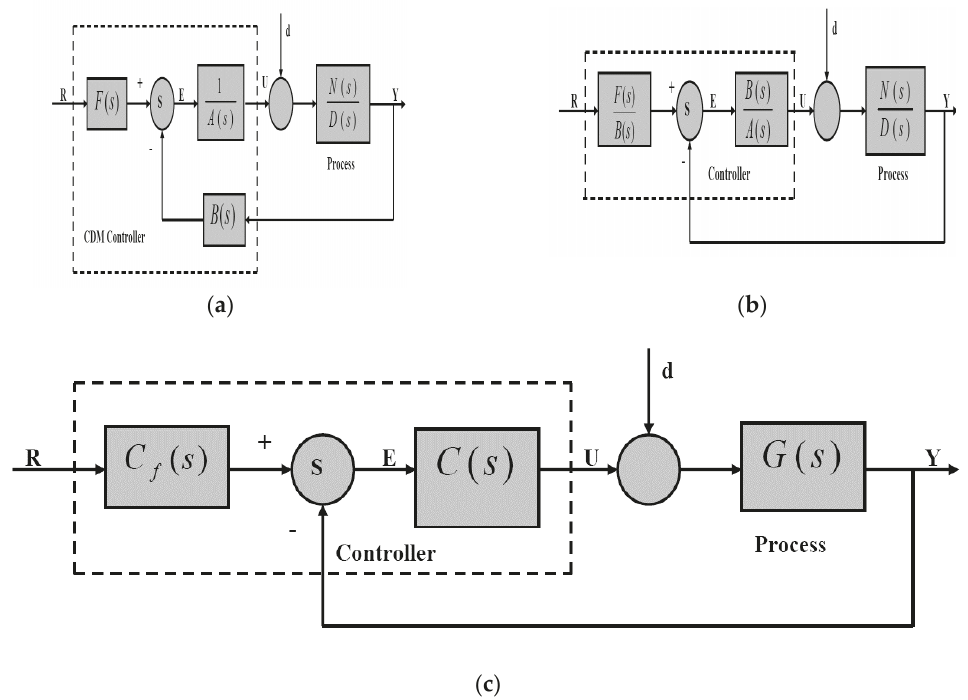
Figure 2. ( a ) General closed loop Coefficient Diagram. ( b ) Equivalent closed loop Coefficient Diagram. ( c ) Coefficient Diagram based closed loop PI Control system.